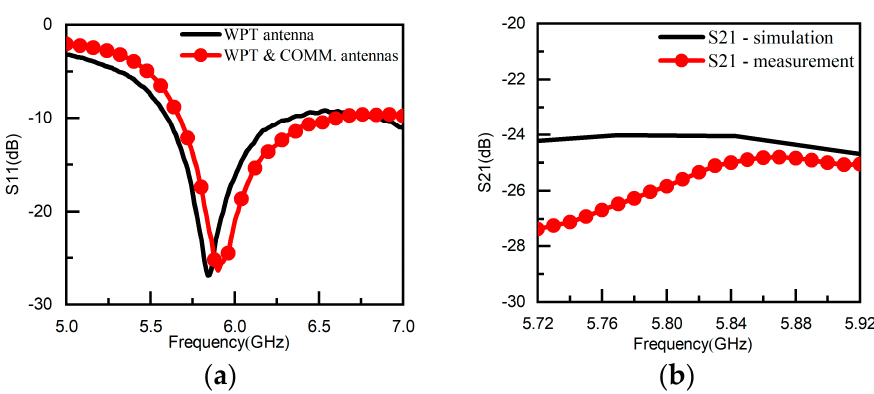
Figure 5. S parameters: ( a ) the measured S11s of WPT ANT w./wo. Comm. ANT and ( b ) S21.